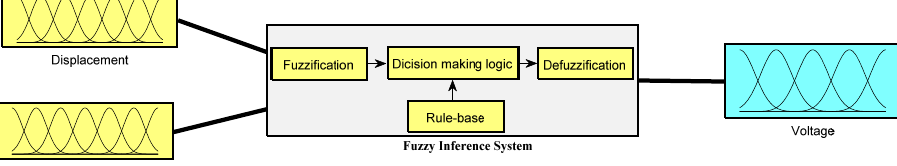
Figure 5. The fuzzy logic control block diagram (Type: Mamdani).